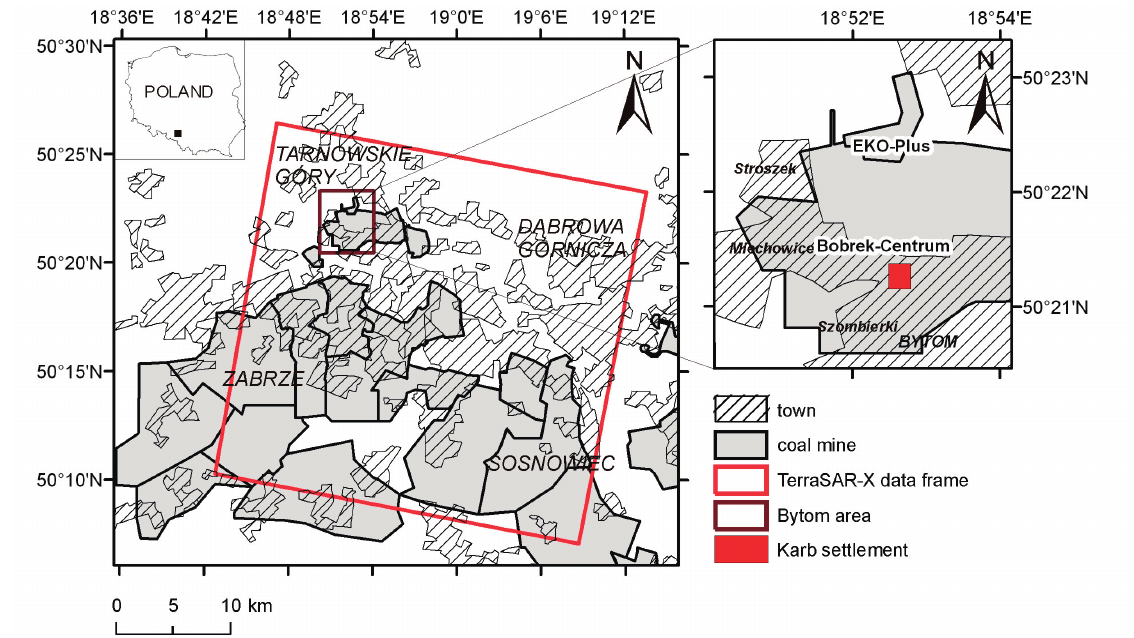
Figure 1. Geographical setting of the study area with TerraSAR-X data frame and the boundaries of coal mining areas in Upper Silesia Coal Basin [30]. On the right Bobrek-Centrum mine, which caused subsidence over Karb district (red rectangle) located in Bytom mining